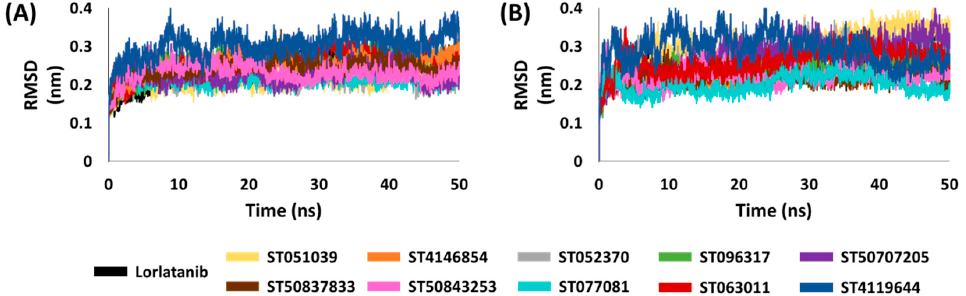
Figure 3. Backbone root-mean-square deviation (RMSD) analysis of ( A ) wild-type (WT) and ( B ) mutated (RT) ROS-1 systems.